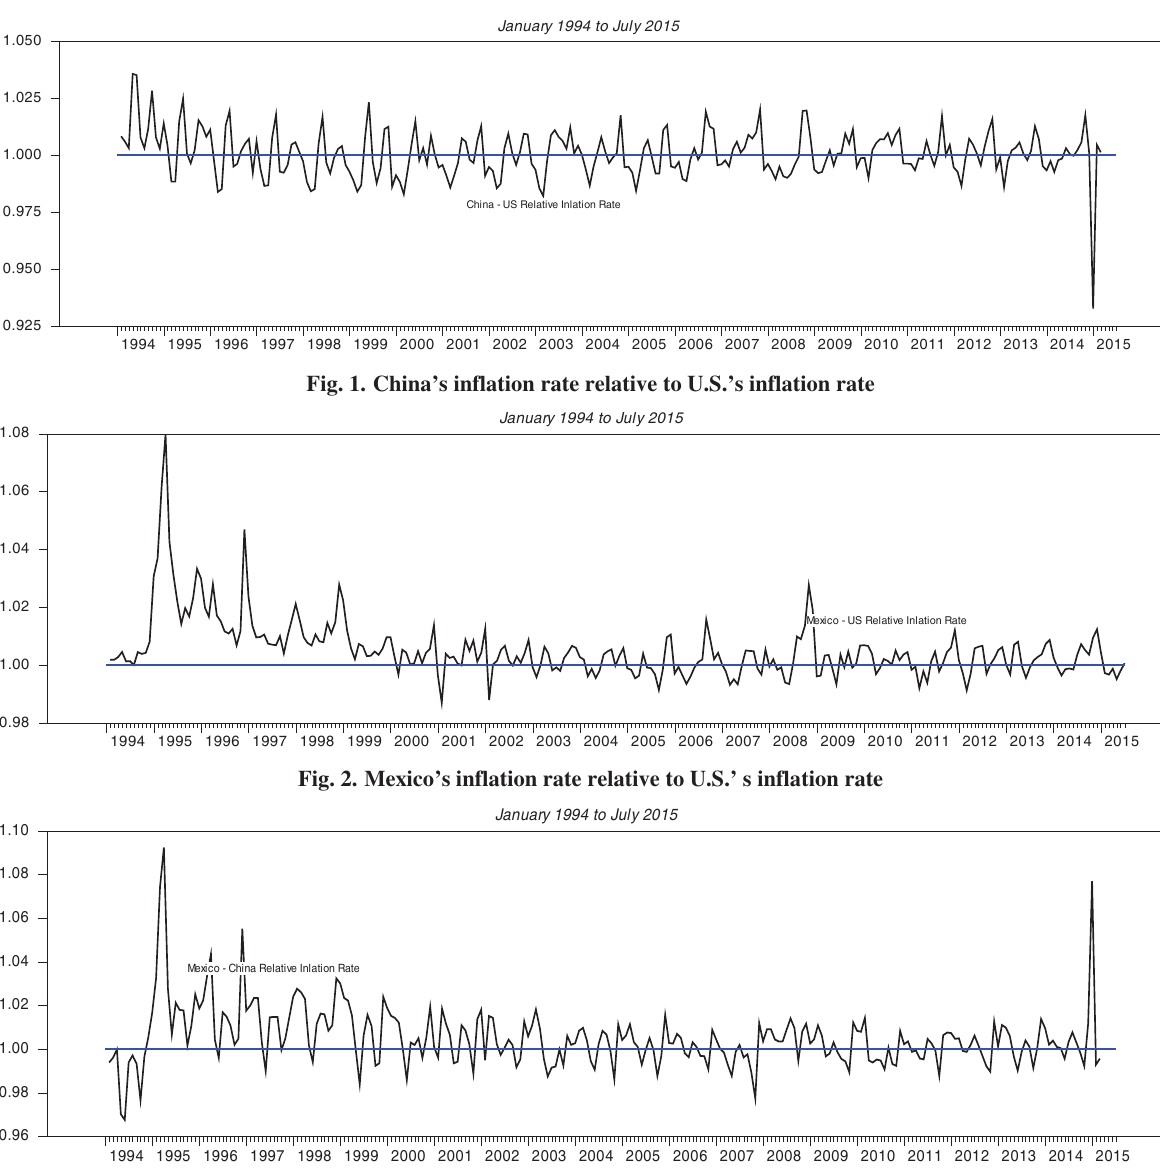
Fig. 3. Mexico’s inflation rate relative to China’s inflation rate